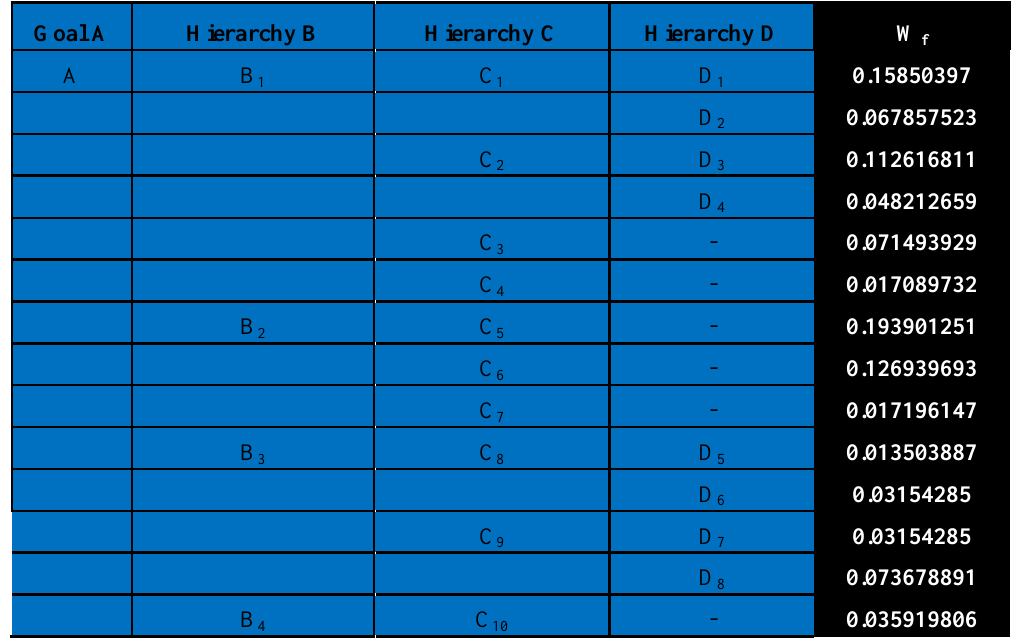
Table 14. Final criteria weights for all